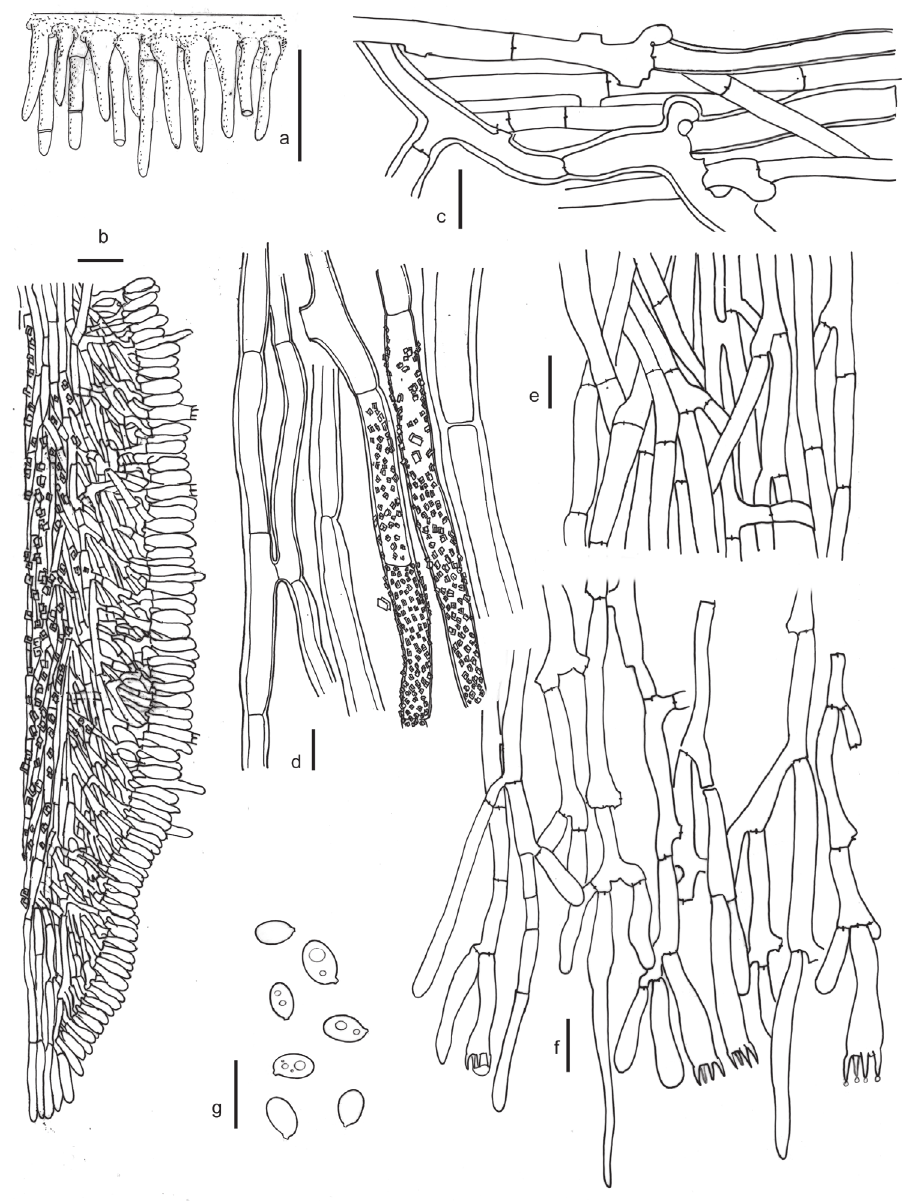
Figure 4. Hydnophlebia canariensis . Collection 17035Tell., MA-Fungi 86622, holotype a Hymenophore b Vertical section through an aculei c Subicular hyphae d Strand hyphae e Aculei hyphae f Subhymenial hyphae, cystidia, and basidia g Spores. Scale bars: a = 1 mm; b = 25 μm; c–g = 10 μm. Drawing by M.